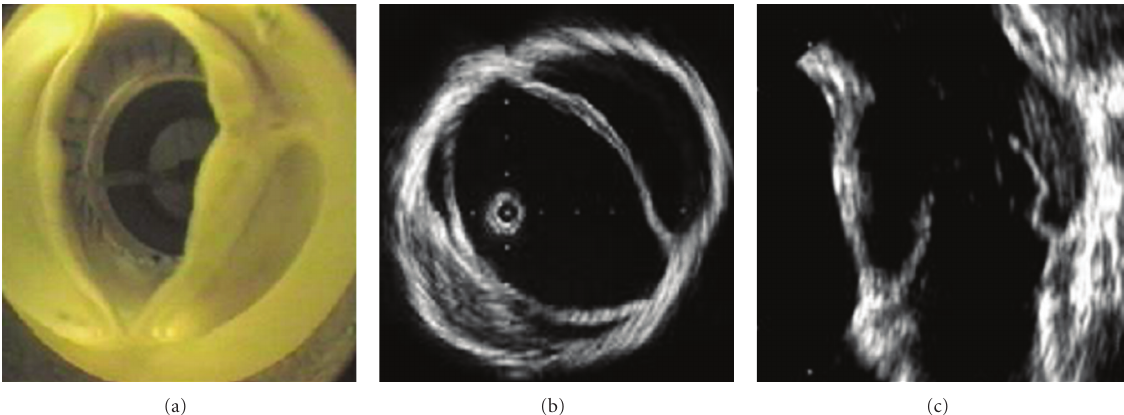
Figure 2: Asymmetric opening of BAV during systole [6].